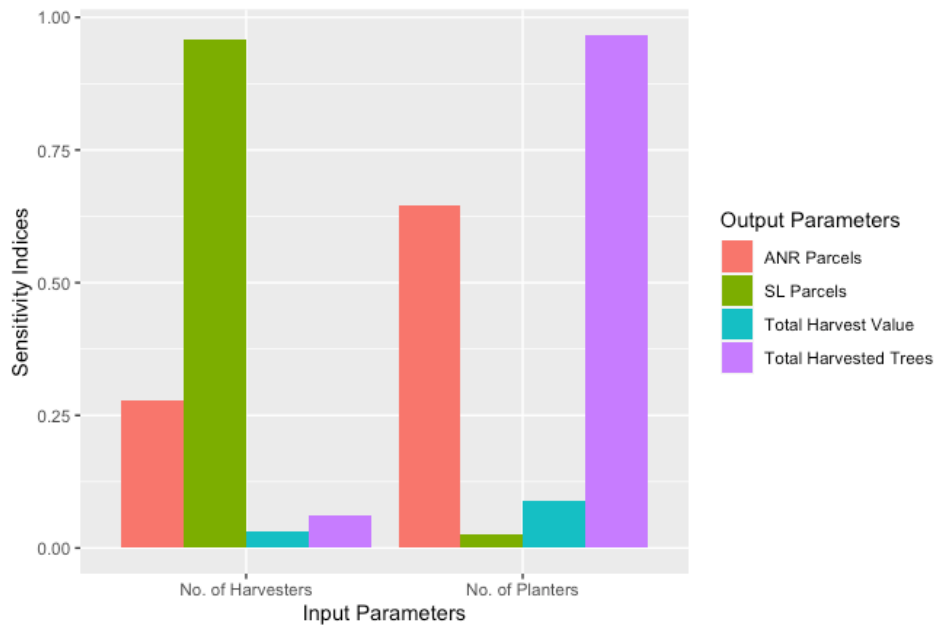
Figure 9. First-order index result of the Sobol analysis on the effect of the number of harvesters and planters on four output values: ANR parcels, harvest profit, remaining trees, and SL parcels.